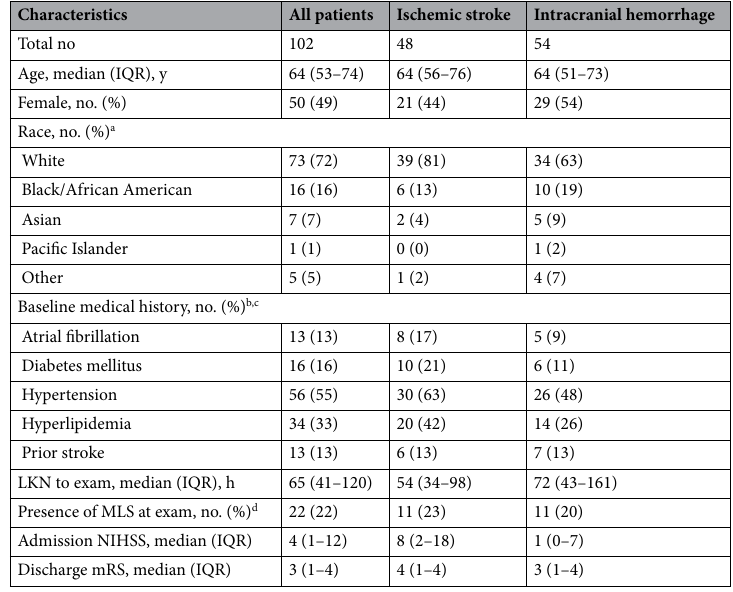
Table 1. Patient demographics and clinical characteristics. IQR, interquartile range; y, year; hr, hour; LKN, last known normal; NIHSS, NIH Stroke Scale; mRS, modified Rankin Scale; MLS, midline shift. a Percentages may not total to 100% because of rounding. b Seline medical history information was unavailable for one patient. c LKN to exam and admission NIHSS information was unavailable for one patient. d Presence of MLS at exam was determined by assessments made on portable MRI images.